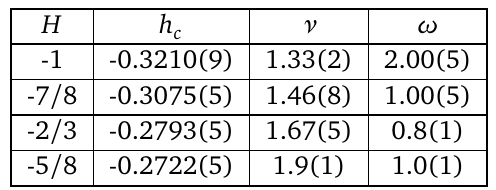
Table 11: Values of the critical level h obtained with the Binder method. The ν c exponent is obtained from equation (61), and the value of the exponent w is obtained from scaling (60), with ν set to (7). The measurements have been taken for the surface